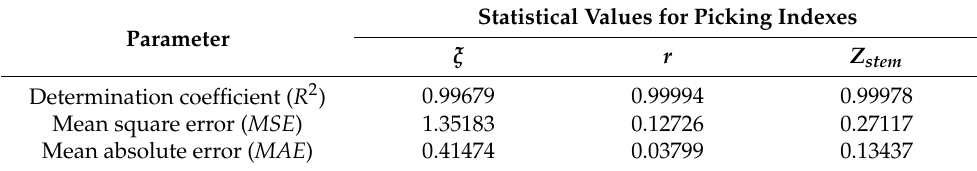
Figure 12. Comparison of experimental values and prediction results for ( a ) ξ ; ( b ) r ; ( c ) Z stem . Table 6. Statistical results of 5-2-12-3 ANN model.